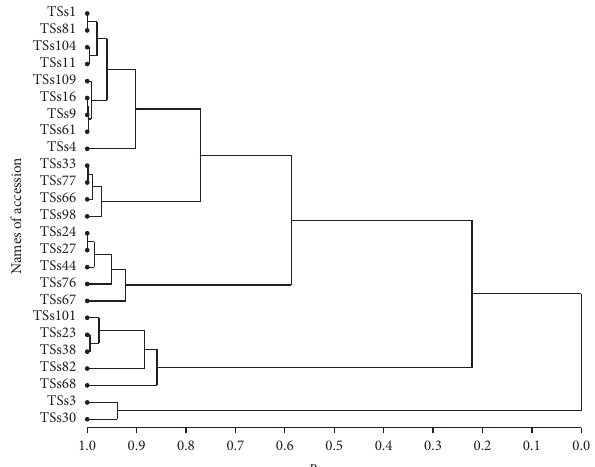
Figure 8: Clustering analysis of antinutrients in unprocessed seeds. TSs: Tropical Sphenostylis stenocarpa .